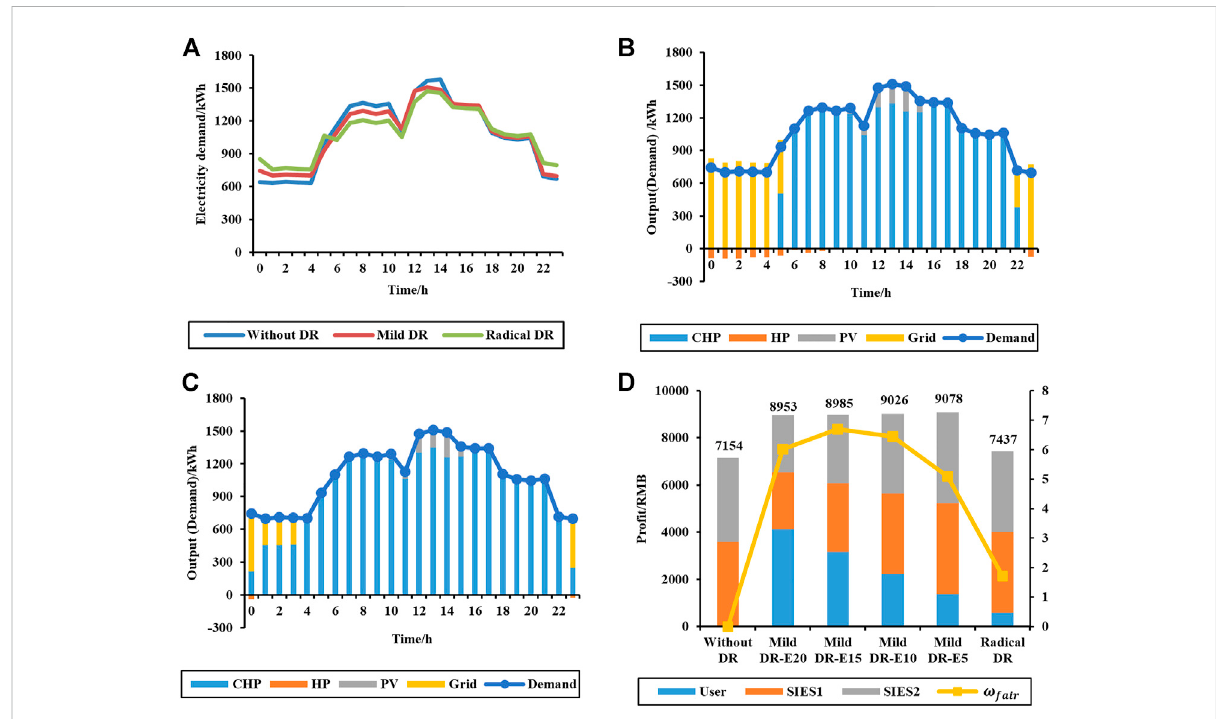
FIGURE 5 Thedemandcurveofdifferentdemandstrategiesinatypicalday (A) ,theenergyoutputofthedifferentdeviceswithnocarbonemissioncontrol (B) and maximum carbon emission (C) , pro fi t of users and SIESs in different scenarios (D)